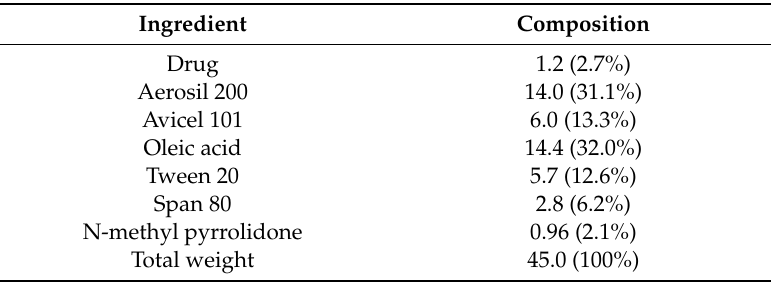
Table 2. Composition of pellets after